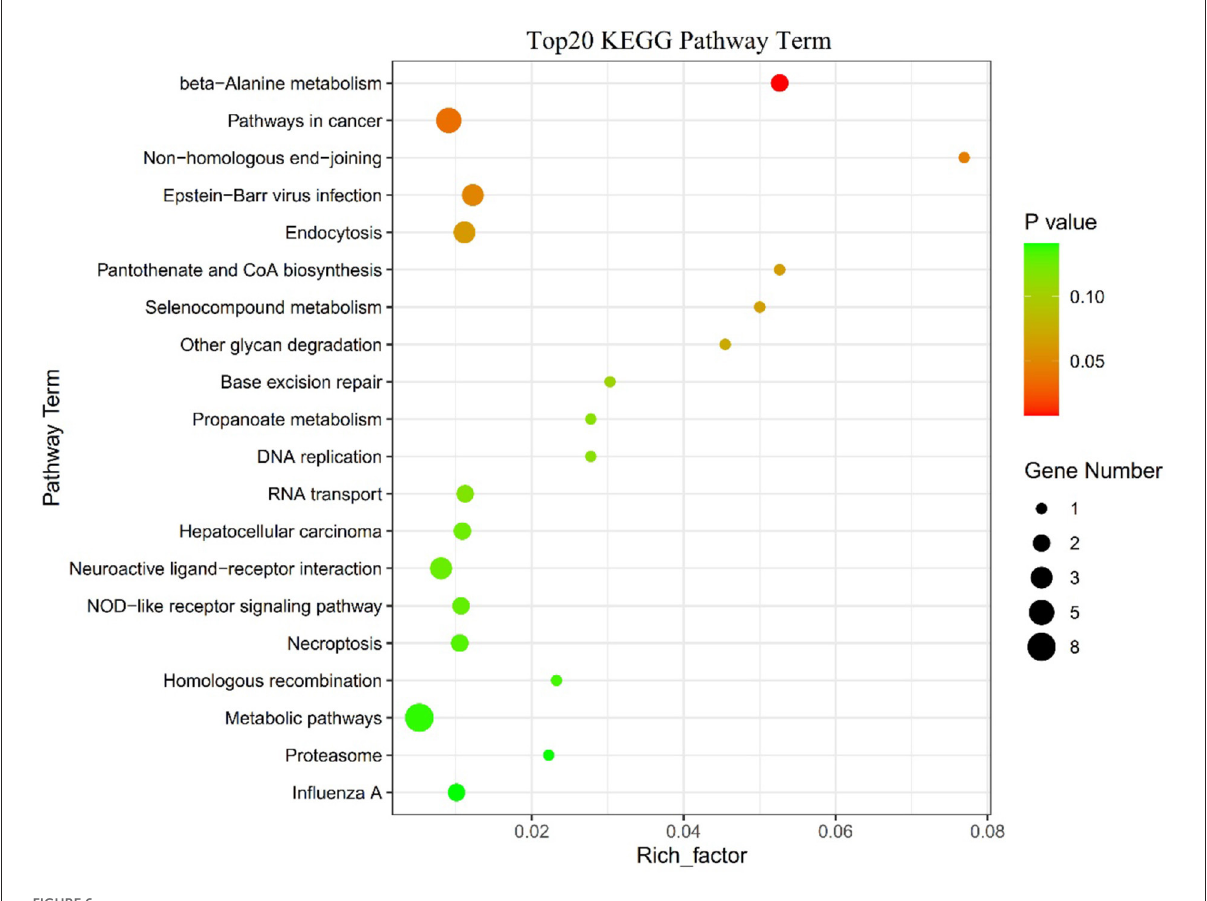
FIGURE6 The top 20 KEGG enrichment pathways.